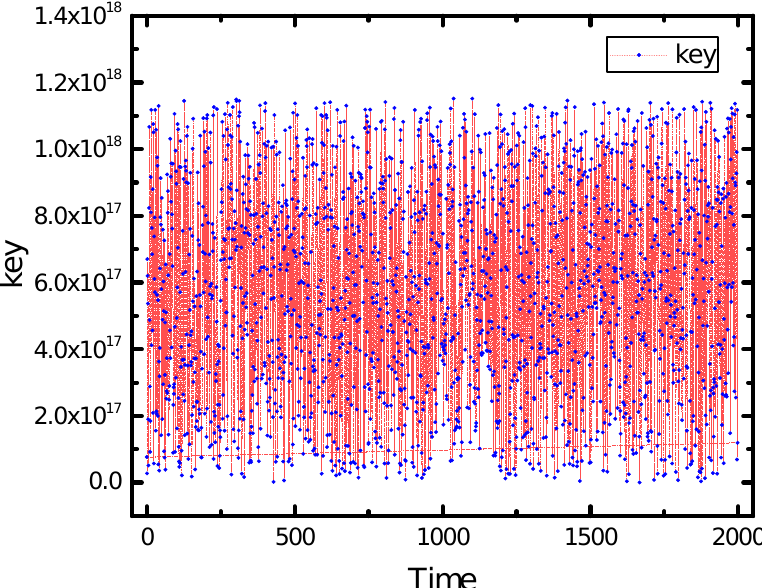
Figure 8. Random key generation, each having half zeros and